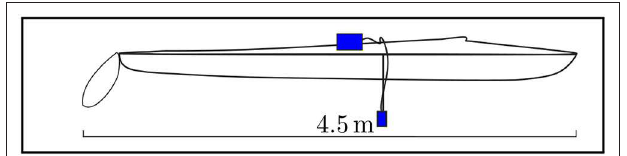
FIGURE 4 | Sensor installation on a canoe for mobile monitoring. The canoe is 4.50 m long. The sensor was positioned in the middle of the canoe at a depth of 0.35 m below the water surface. For user-friendly handling of the sensor, it is important that it can be installed quickly and easily. Due to the low weight, the installation can be adapted to the respective installation situation.